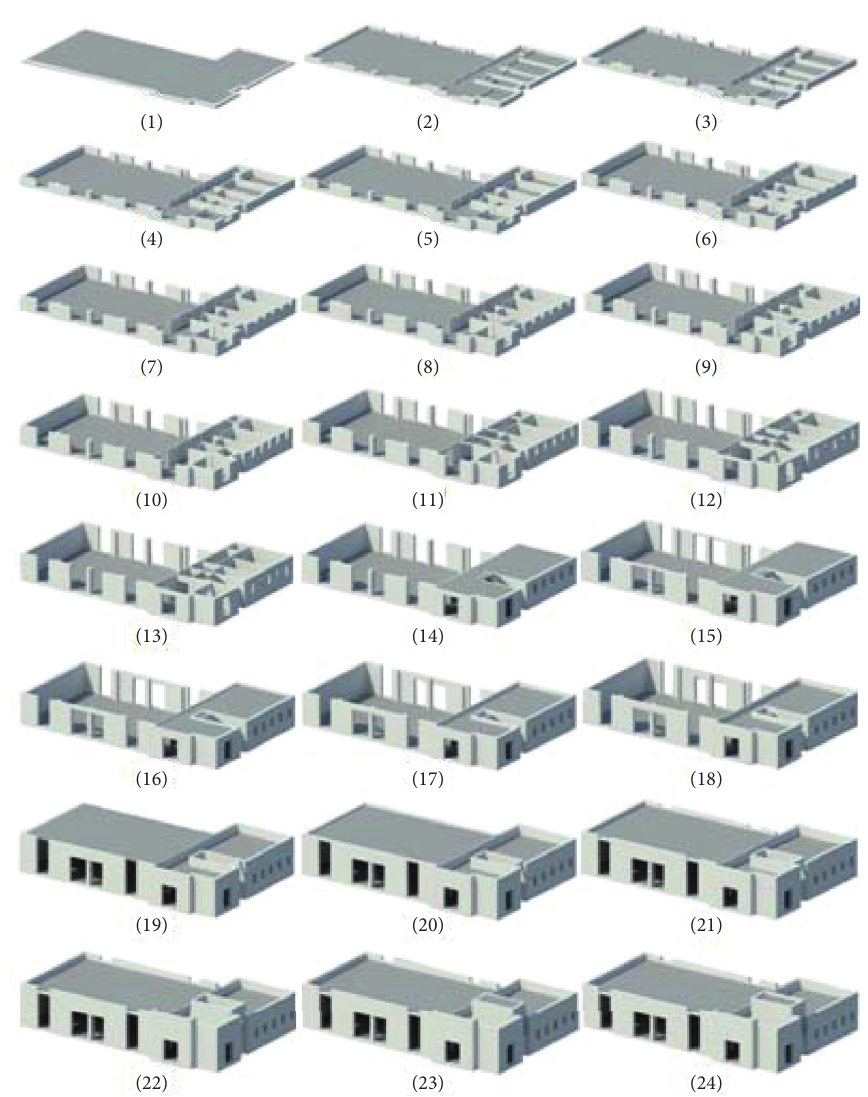
Figure 20: Ras Alain Multipurpose Hall construction stages by CC.